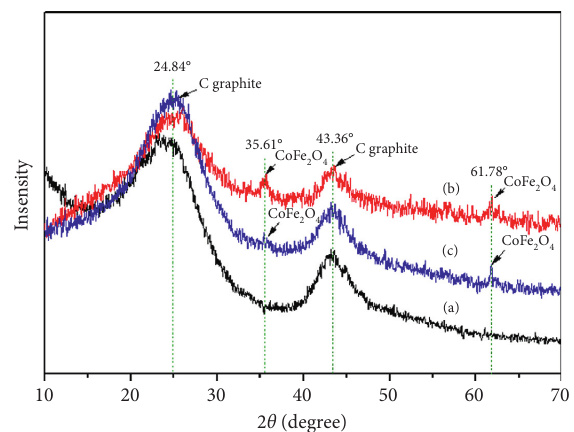
Figure 11: XRD graphs of (a) CAC, (b) CAC/CoFe CAC/CoFe 2 O 4 200–RhB.